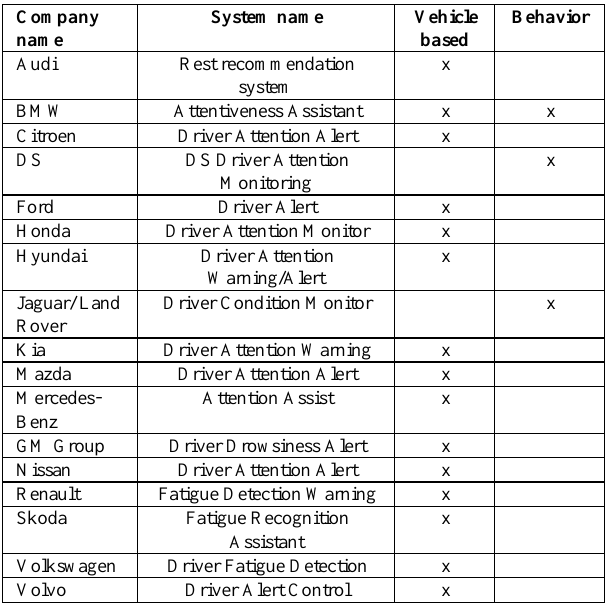
Table 1. Comparison of the top 20 car